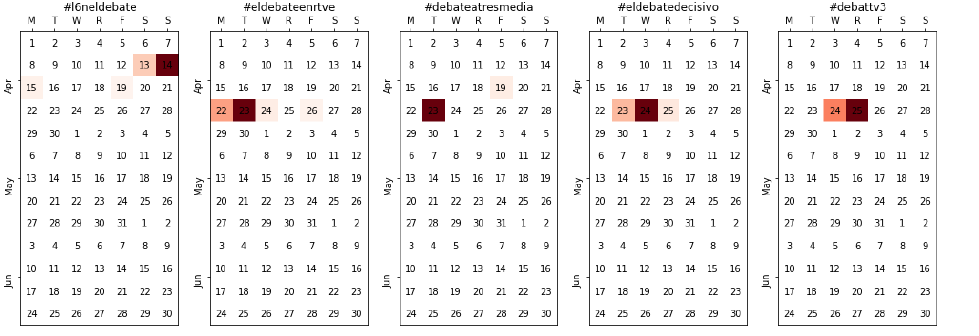
Figure 11. Calendar heatmap for the multiple televised debates with candidates.